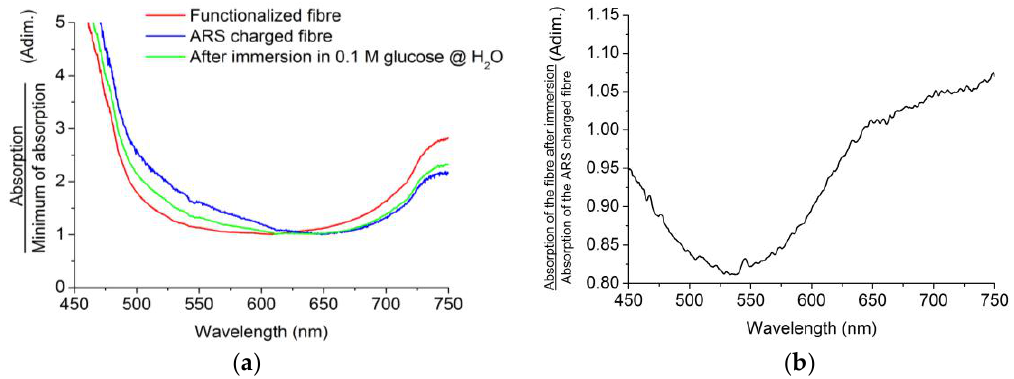
Figure 9. ( a ) Normalized absorption curves of the probe before and after 10 min of immersion in 0.1 M glucose solution in H 2 O; ( b ) division of ARS-charged absorption and post-immersion absorption curves. Regarding the physiological media, PBS and TRIS, their results are shown in Figure 10.